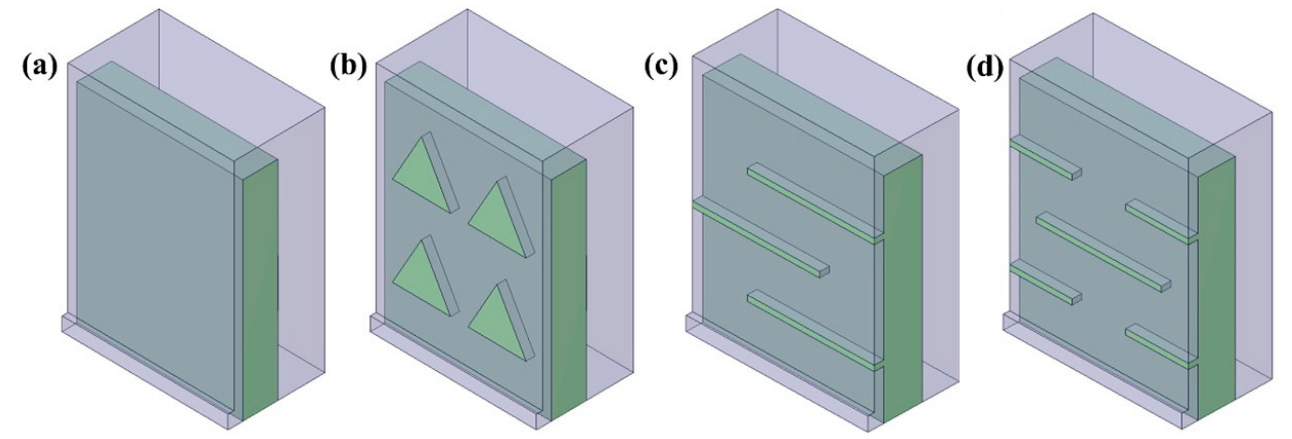
Figure 2. Four different flow paths to change internal airflow patterns. ( a ) Basic model, ( b ) Model 1, ( c ) Model 2, ( d ) Model 3.